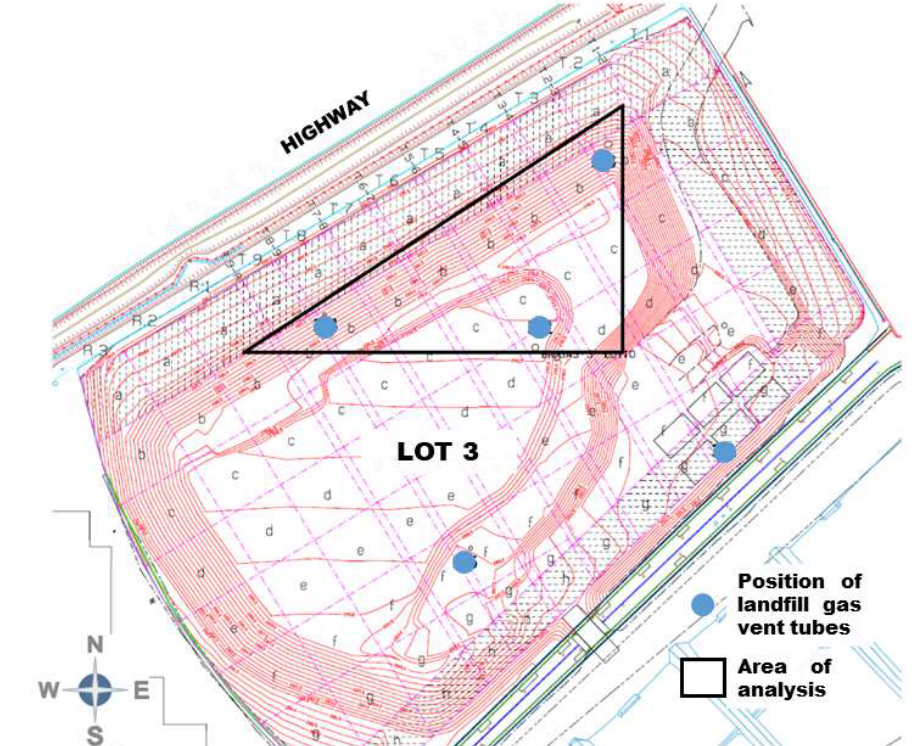
Figure 5. Location of sampling points for ambient air monitoring.